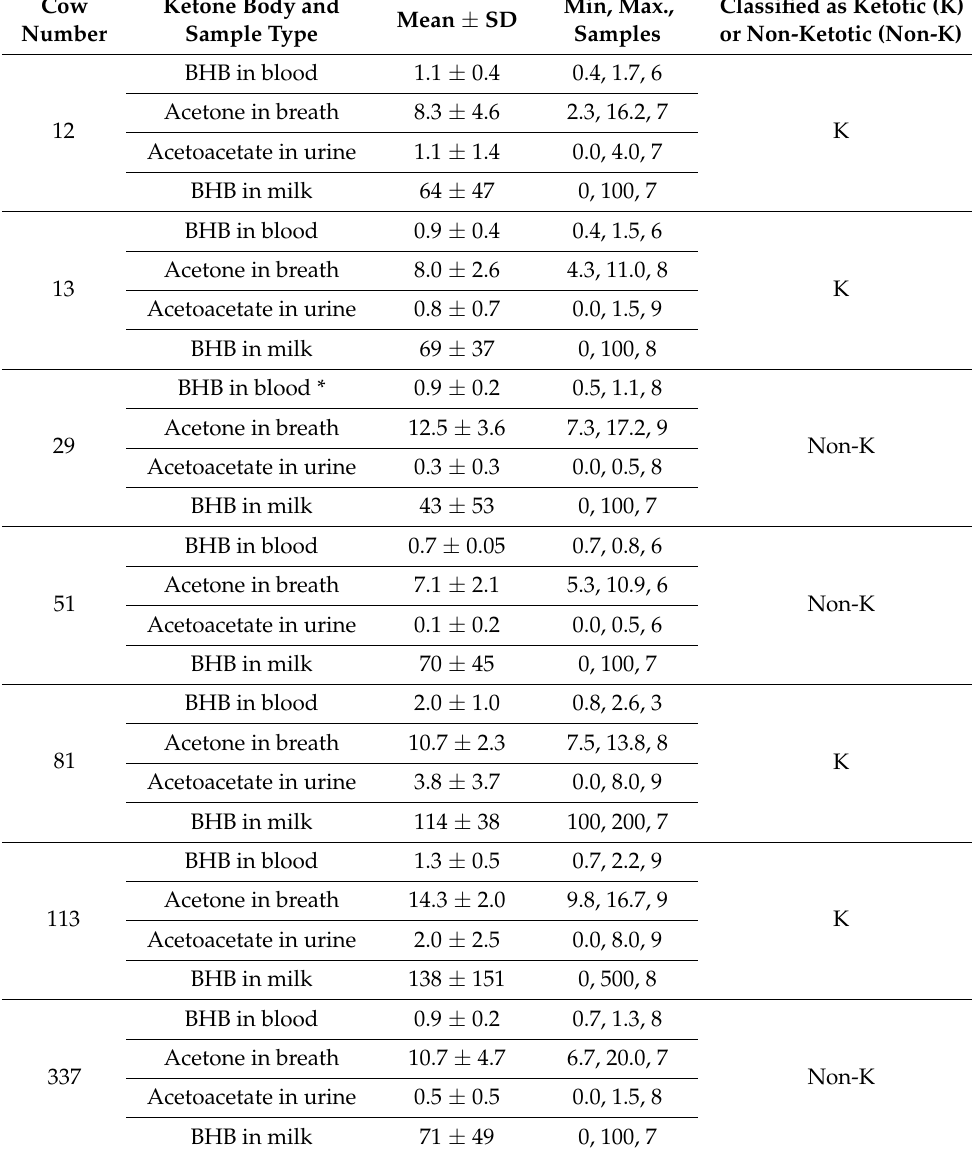
Table 2. Descriptive statistics of ketone bodies in blood, breath, urine and milk samples, and the ketosis status for all cows in the study ( n = 7). Cow Ketone Body and Number Sample